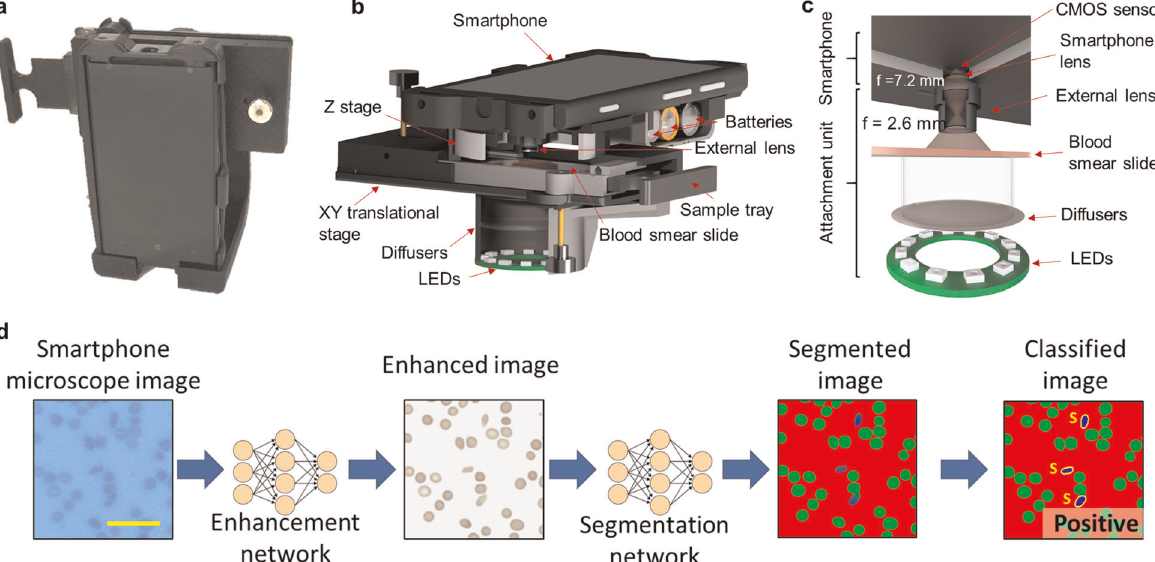
Fig. 1 Field portable smartphone based bright fi eld microscope and its principle of detection. a A photograph of the smartphone-based bright fi eld microscope. Schematic illustration of b the design of the portable microscope in detail and c the light path. d Deep learning work fl ow for sickle cell analysis. Scale bar indicates 20 μ